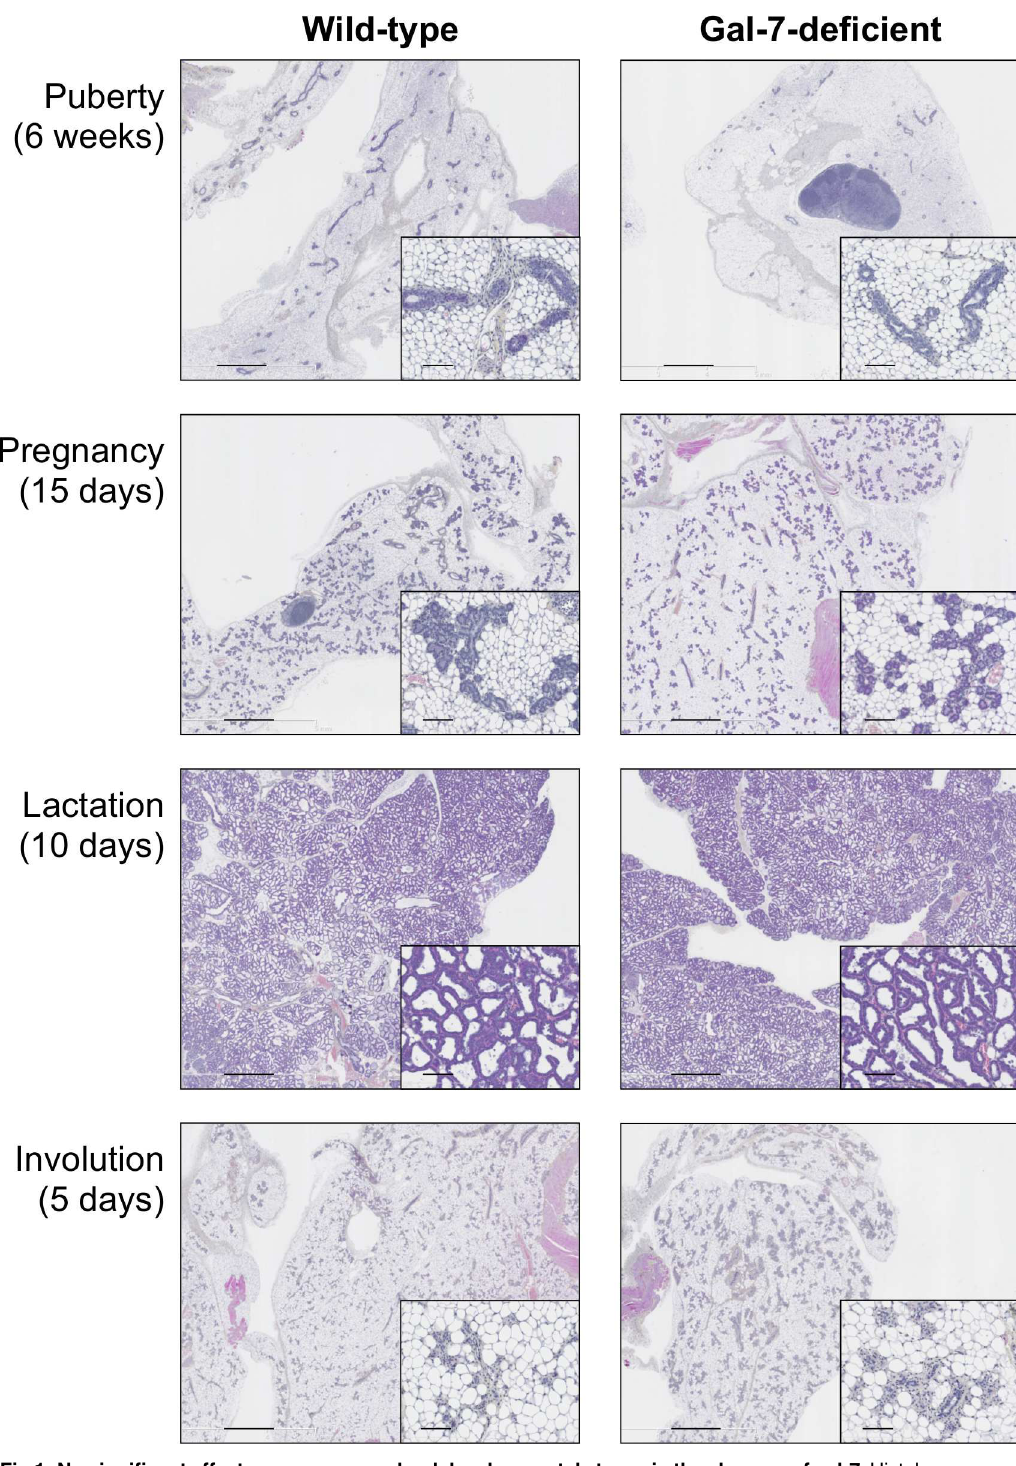
Fig 1. No significant effectson mammary gland developmental stages in the absence of gal-7. Histology assessment of wholemammary glands(H&E stained) of wild-typeand galectin-7-deficient mice. Three mice were used for each group of mammary gland at three distinct stages: puberty (6 weeks of age), pregnancy (5, 10 and 15 days), lactation (0, 5 and 10 days) and involution (1 and 5 days). Scale bars, 1 mm and 100 μ m (insets).